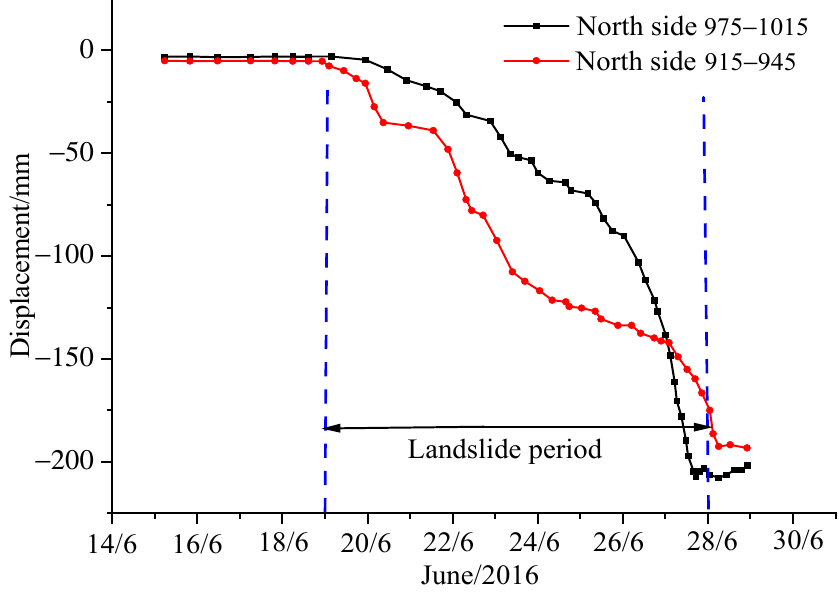
Figure 4. Displacement curves of the north end slope from June 16 to June 29, 2016.